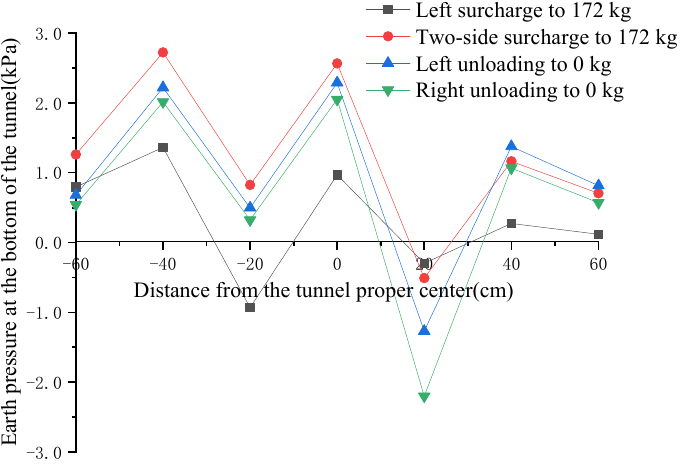
Figure 24. Variation in additional soil pressure at the bottom of the tunnel under different surcharges in Case 4.